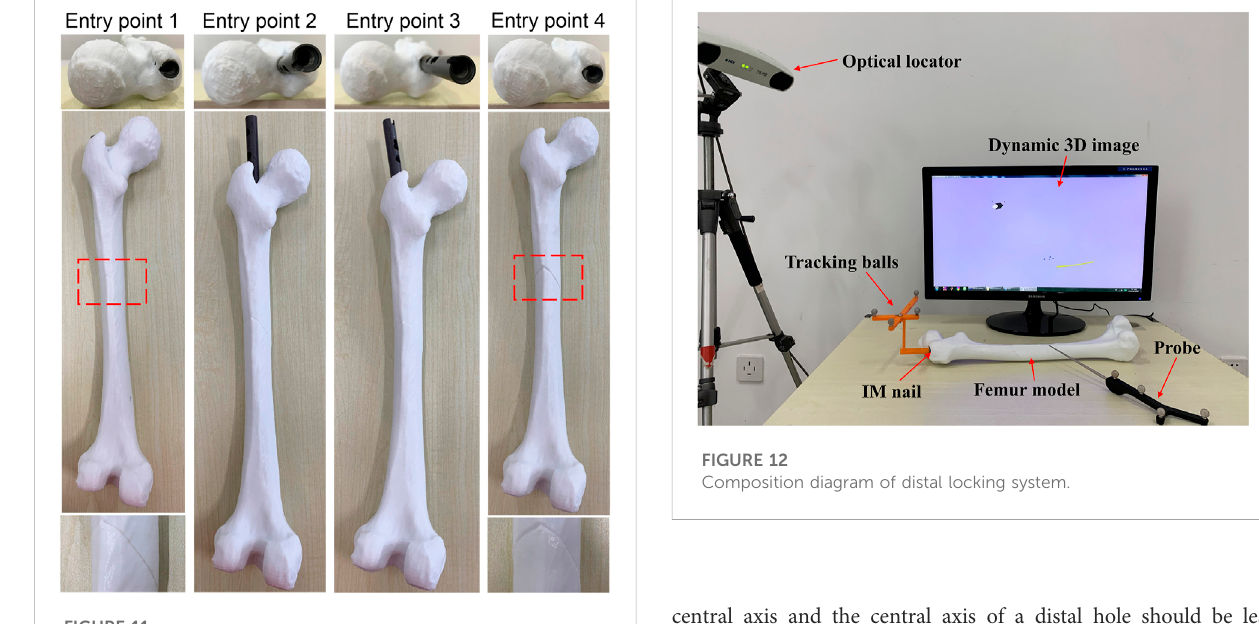
FIGURE 11 The result of entry point valuation experiments.